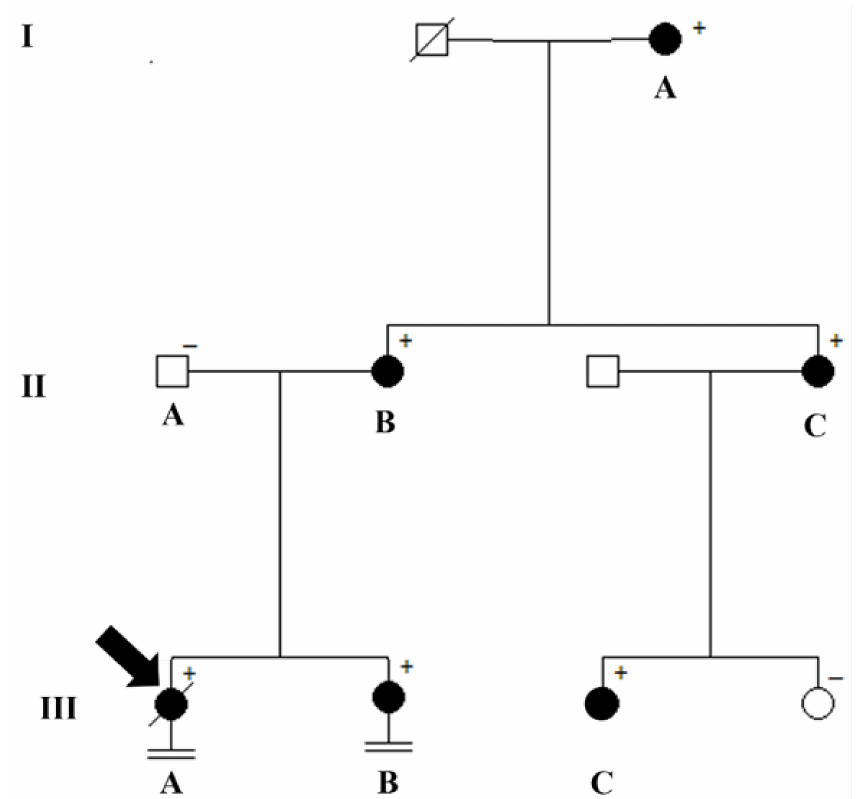
Figure 1. Family pedigree. Squares and circles indicate male and female family members, respectively. Symbols with a single slash mark are deceased family members. Arrows indicate proband. Open symbols indicate unaffected family members, and symbols with a cross indicate family members who did not have a clinical evaluation. The presence (+) or absence ( − ) of a desmoplakin (DSP) variant is indicated for family members with DNA samples available for